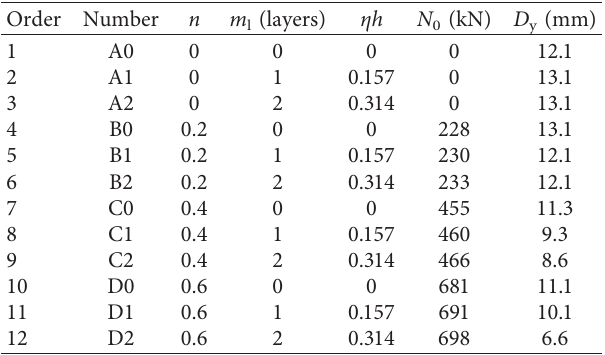
Table 4: Parameters of C-CF-CFRP-ST specimens.